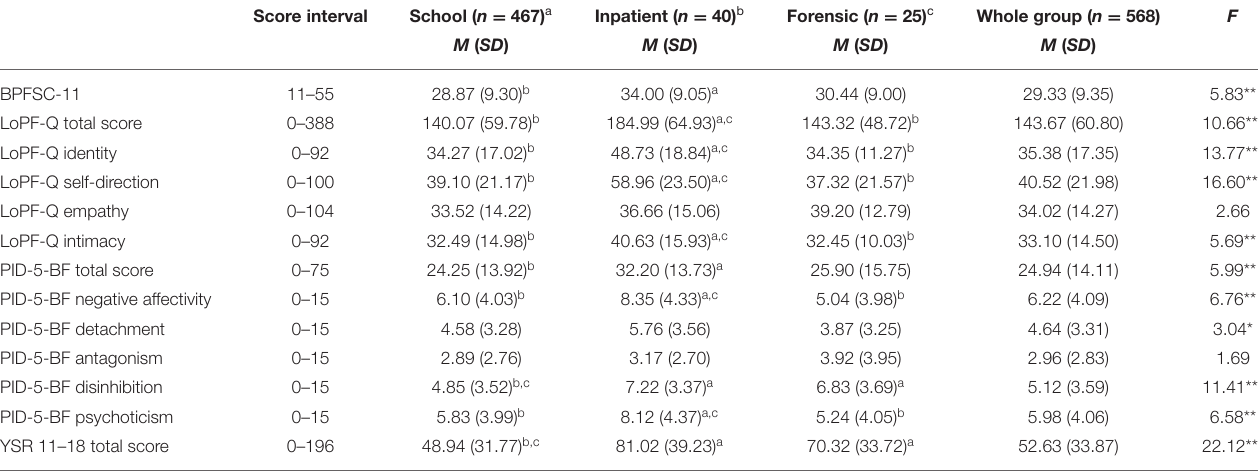
TABLE 1 | Descriptive statistics by group for observed variables.